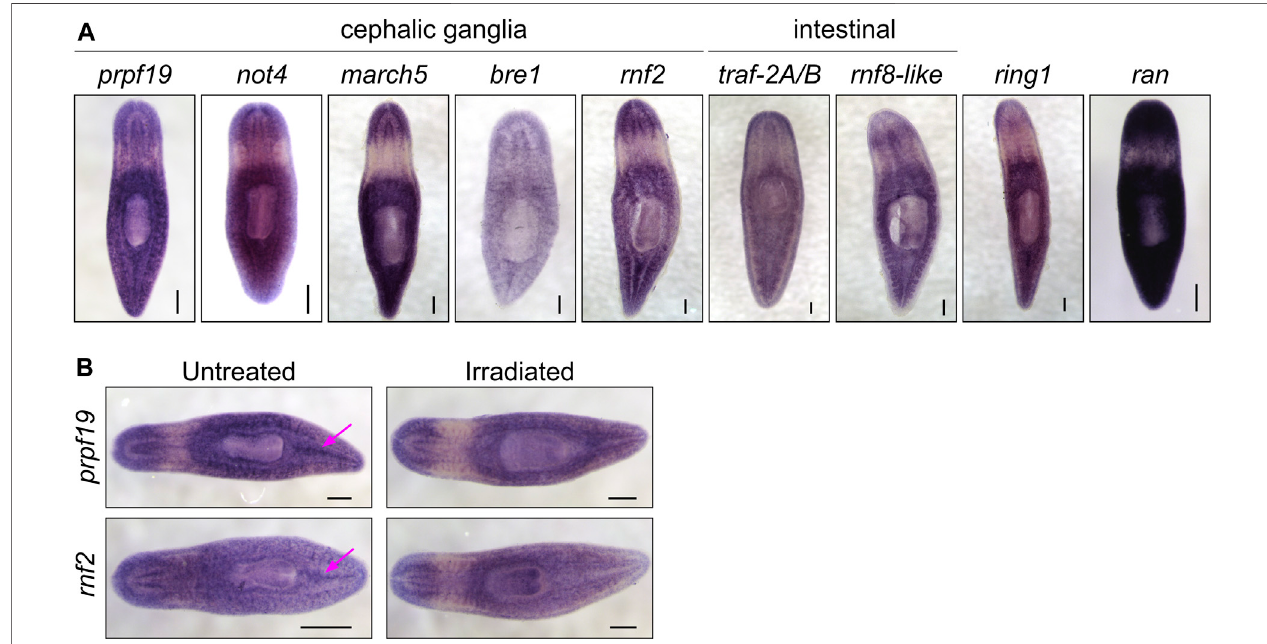
FIGURE2|(A) WISHexpressionpatternsforgenesshowingphenotypesintheRNAiscreen.Allthegenesexaminedwereexpressedthroughouttheparenchyma; a subset of genes displayed enriched expression near the cephalic ganglia or the intestine. (B) WISH analysis of prpf19 and rnf2 in untreated controls and irradiated worms. Arrows show expression in regions enriched in stem cells in untreated worms that are undetectable in irradiated worms. Scale bars (cid:1) 200 μ m.